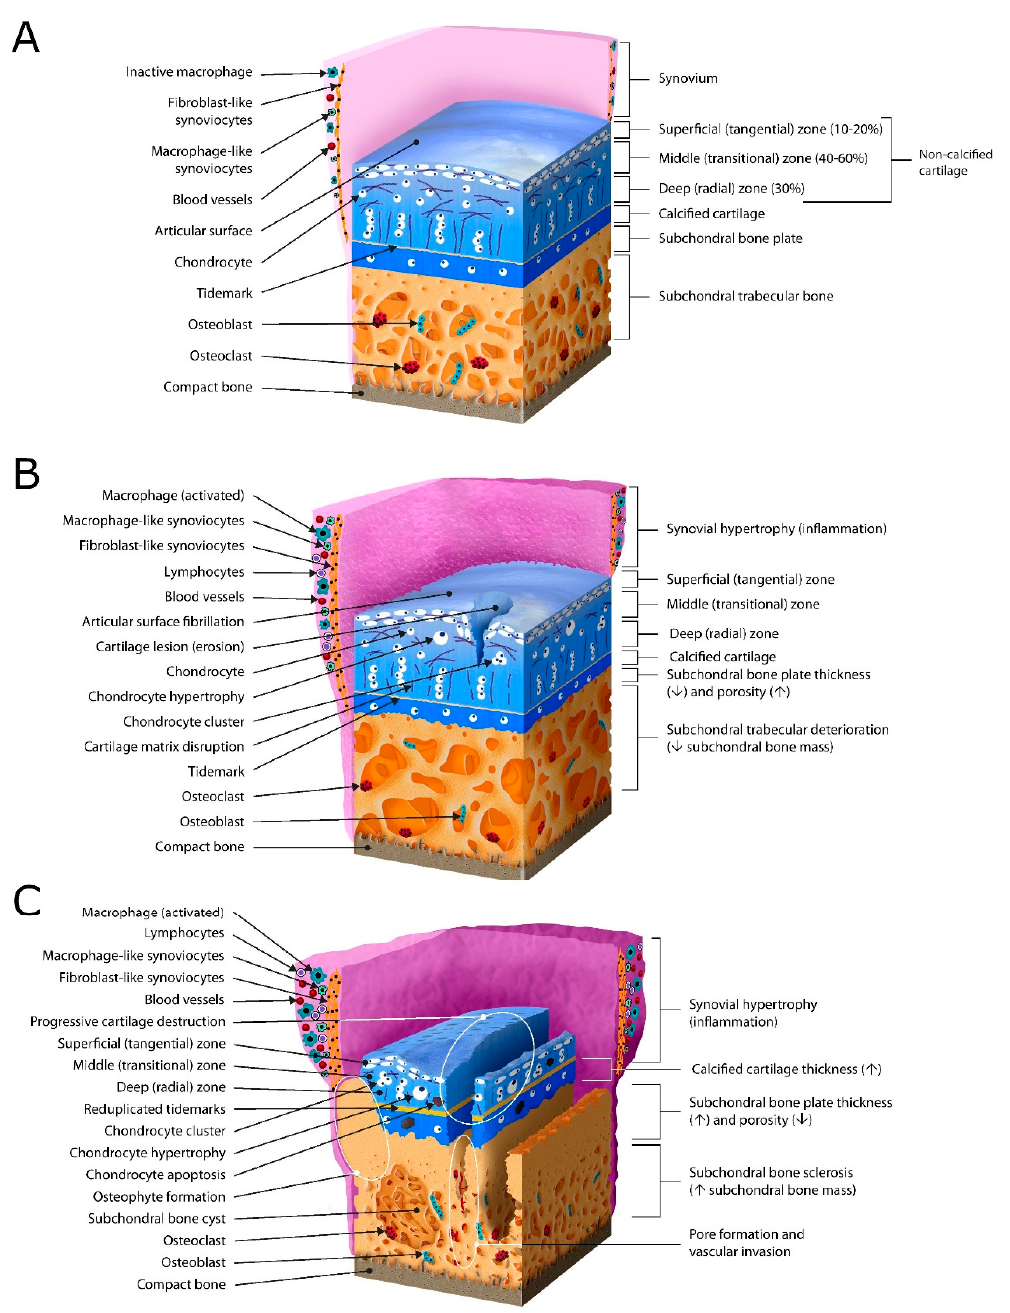
Figure 2. Microarchitectural and histologic changes of articular cartilage, subchondral bone and synovium in osteoarthritis. ( A ) Representation of normal joint structure and normal histologic state of the main tissue involved in osteoarthritis; ( B ) Early-stage osteoarthritis changes in articular cartilage, subchondral bone and synovium. Shallow cartilage erosions of the superficial tangential zone and middle transitional zone causing disruption of the extracellular matrix can be seen. Secondary chondrocyte hypertrophy and clustering is present as well. Changes to other joint tissues, mainly the reduction in subchondral bone mass, synovial thickening and inflammatory cells (lymphocytes) migration, together with changes in cellular activity and count, are depicted. ( C ) Late-stage osteoarthritis changes of involved tissues. Full-thickness cartilage erosions reaching the subchondral bone, chondrocyte apoptosis, subchondral bone sclerosis, osteophyte and subchondral cysts formation alongside vascular infiltration are shown. Further synovial thickening with immune cells infiltration and increased vascularization is also